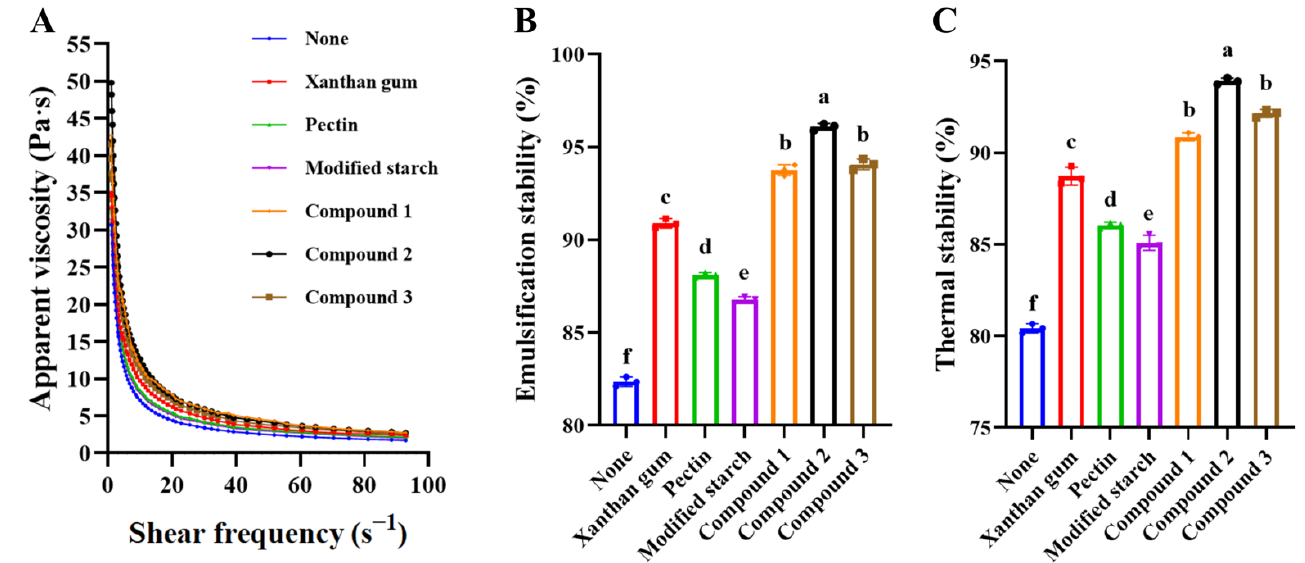
Figure 1. Effects of different stabilizers on the ( A ) apparent viscosity, ( B ) emulsification stability and ( C ) thermal stability of SOB-substituted mayonnaise. Compound 1 represented xanthan gum, pectin and modified starch in a ratio of 1:1:2, compound 2 represented xanthan gum, pectin and modified starch in a ratio of 2:1:1, and compound 3 represented xanthan gum, pectin and modified starch in a ratio of 1:2:1. Different lowercase letters indicated significant difference ( p < 0.05 ).